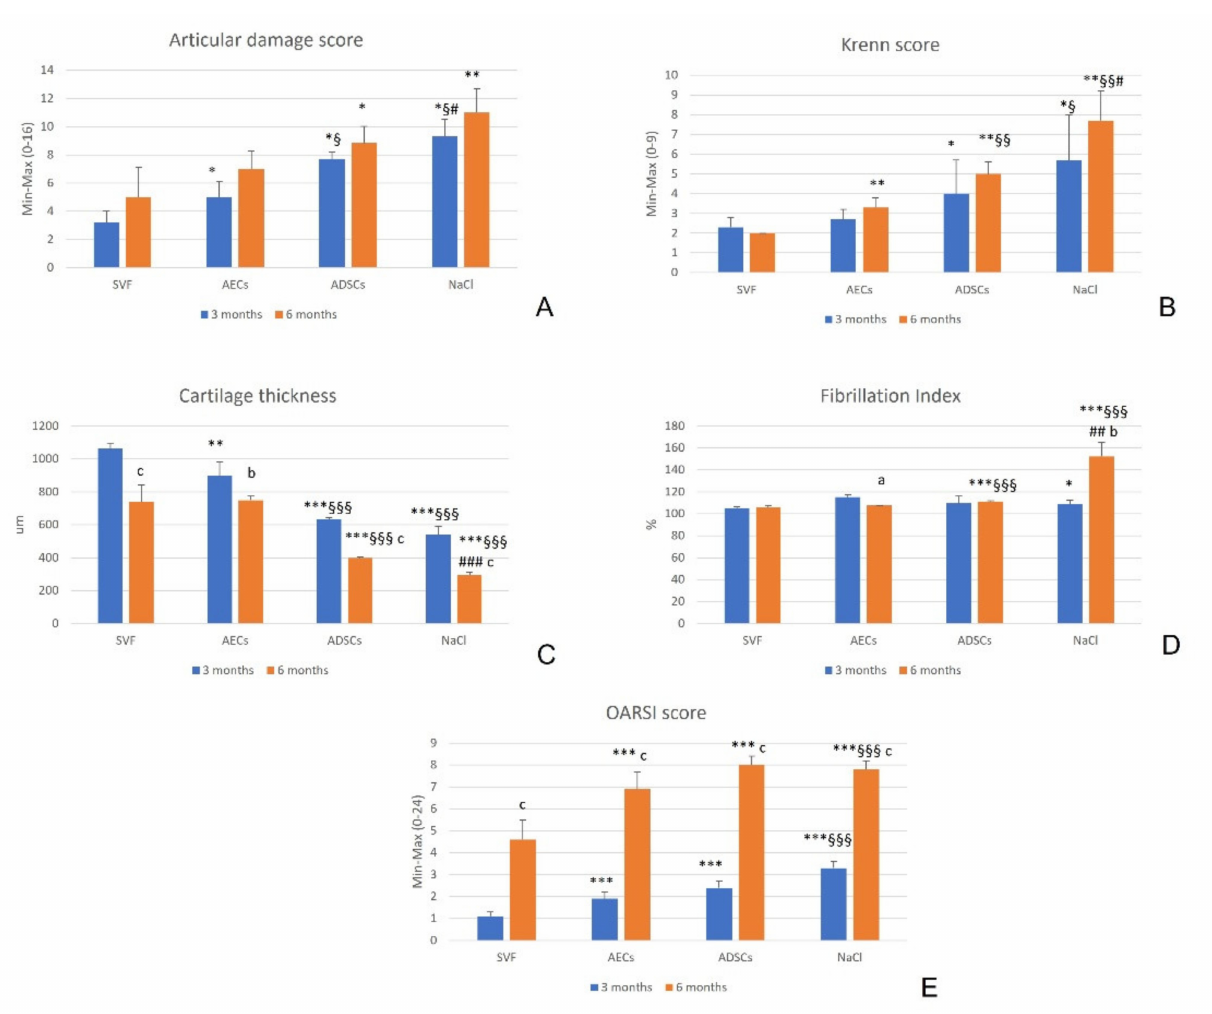
Figure 3. Mean and standard deviation (SD) of macroscopic score ( A ), Krenn score ( B ), cartilage thickness (CT) ( µ m) ( C ), fibrillation index (FI) (%) ( D ), and OARSI score ( E ), for all treatment groups: SVF, AECs, ADSCs and NaCl, at 3 and 6 months. N = 6. *, p < 0.05; **, p < 0.005; ***, p < 0.0005: SVF vs. AECs, ADSCs and NaCl. §, p < 0.05; §§, p < 0.005; §§§, p < 0.0005: AECs vs. ADSCs and NaCl. #, p < 0.05; ##, p < 0.005; ###, p < 0.0005: ADSCs vs. NaCl. a, p < 0.05; b, p < 0.005; c, p < 0.0005: 6 months vs. 3